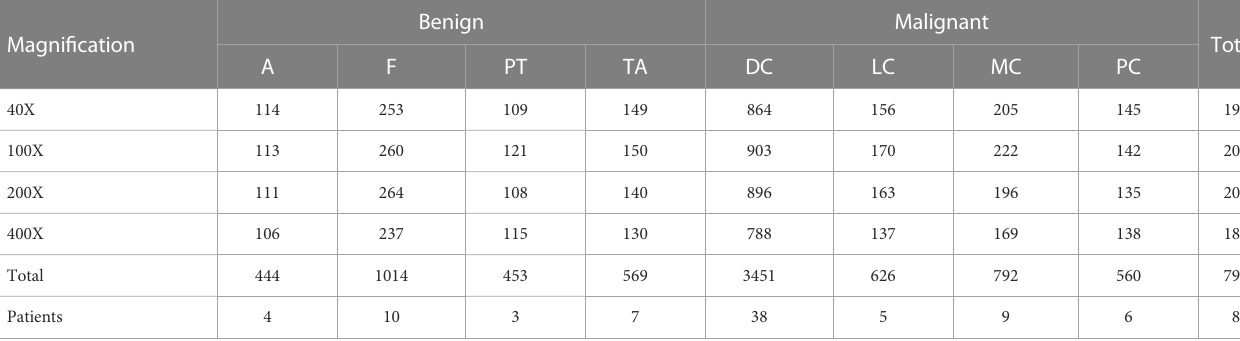
TABLE 1 Summary of the contents of